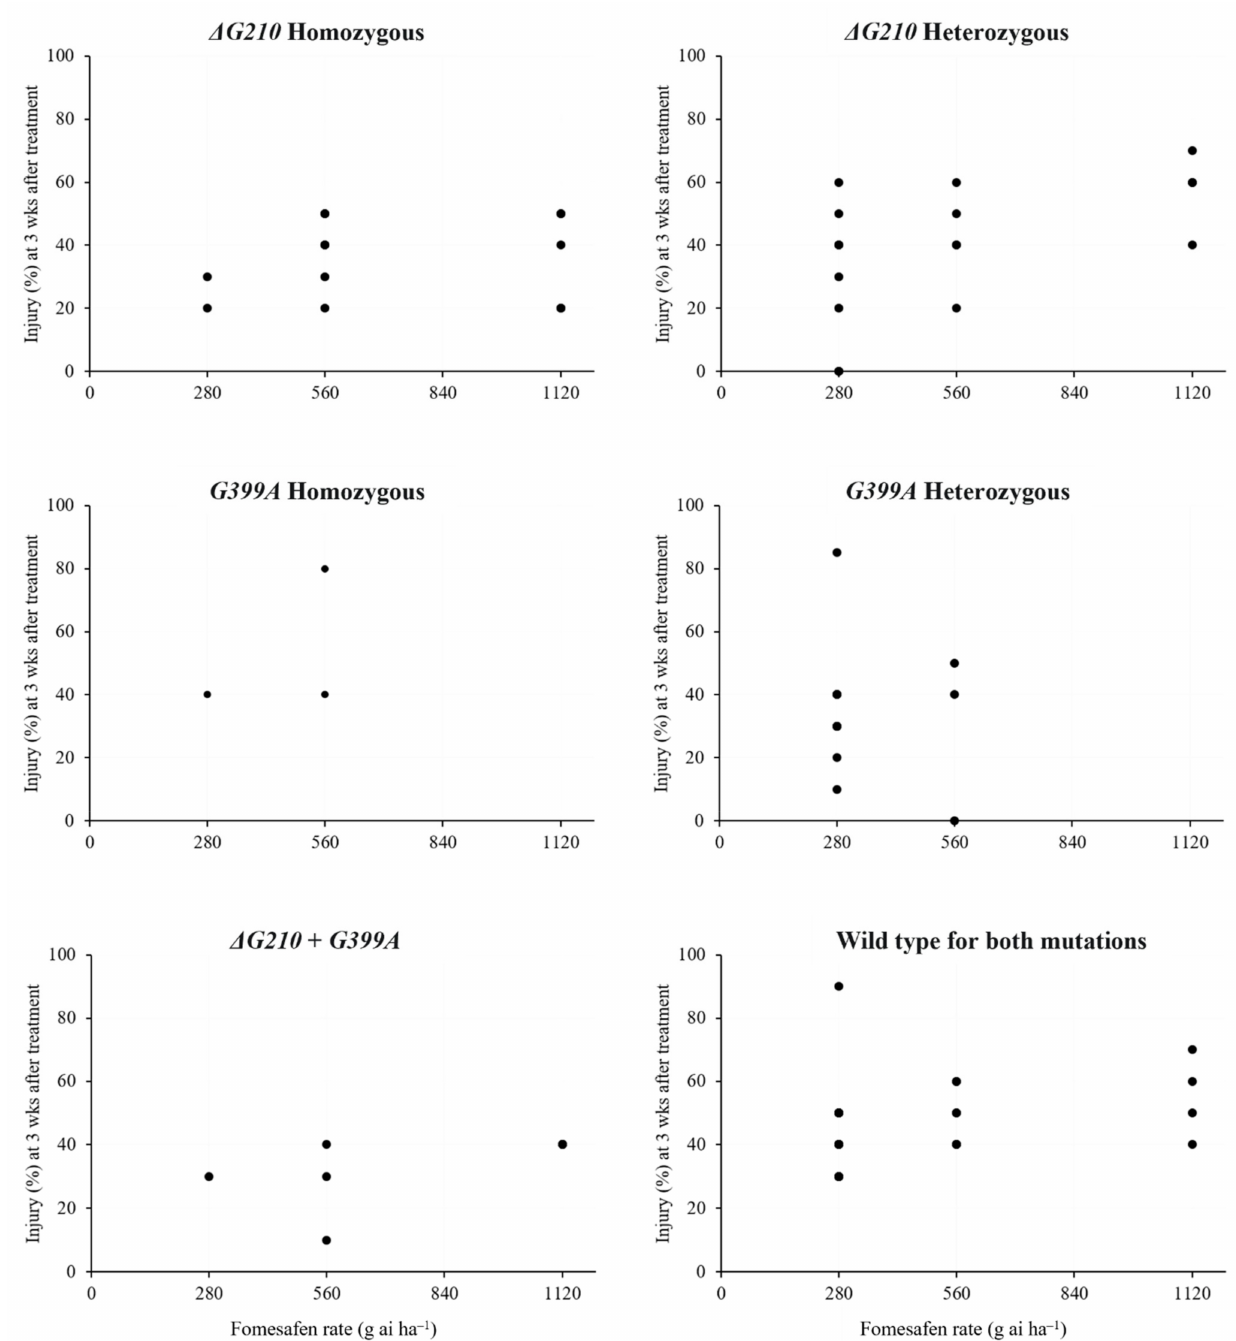
Figure 3. Injury (%) of Amaranthus palmeri survivors from treatments with 280, 560 and 1120 g ha − 1 fomesafen (Flexstar ® 1.88 EC) + 0.5% v / v nonionic surfactant separated by genotype. Each dot in the graphs may represent multiple